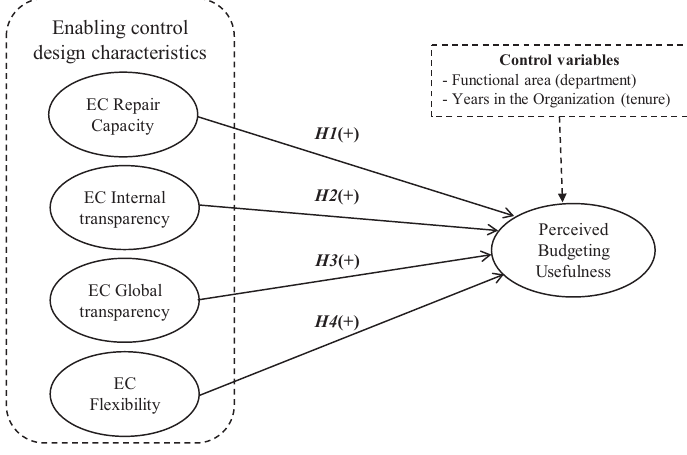
Figure 1. Theoretical model